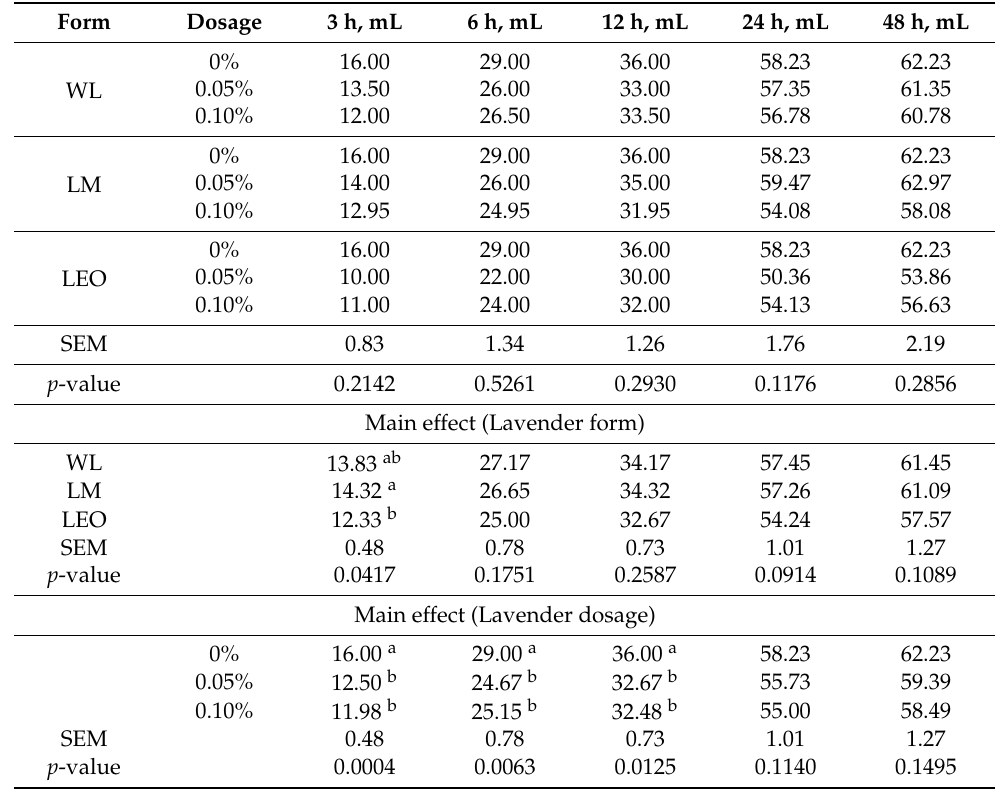
Table 3. The effect of adding different forms of lavender on the cumulative gas production of concentrate feed of dairy